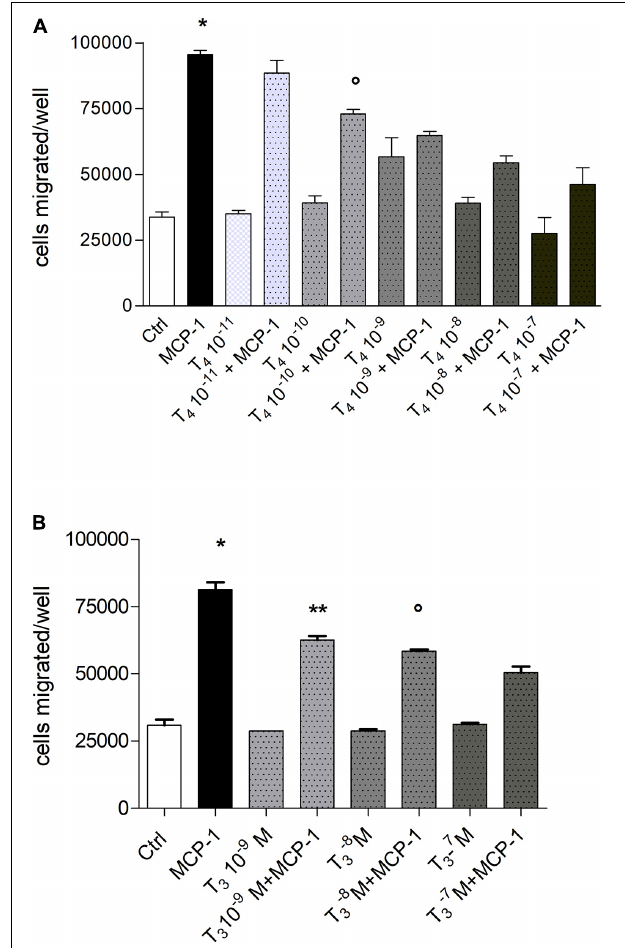
FIGURE 2 | (A) Dose–response in a wide concentration range of T 4 (10 − 7 –10 − 11 M) on the migration induced by monocyte chemoattractant protein 1 (MCP-1; 100 ng/ml). Results are reported as mean ± SD of n = 3 different experiments carried out in duplicate. * p < 0.01, at least, vs. all but T4 10 − 11 M + MCP-1; ◦ p < 0.01 vs. MCP-1 and T 4 10 − 8 M + MCP-1. (B) Dose–response of T 3 (10 − 7 –10 − 9 M) in the migration induced by MCP-1 (100 ng/ml). Results are reported as mean ± SD of n = 3 different experiments carried out in duplicate. * p < 0.001vs. all; ** p < 0.001 vs. MCP-1; ◦ p < 0.05 vs. T 3 10 − 7 M +